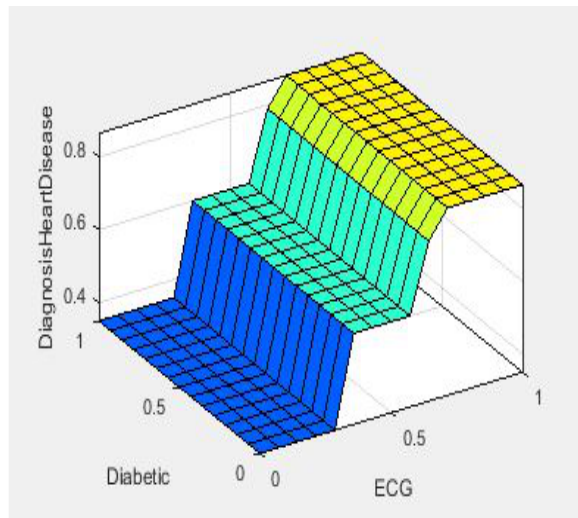
Fig. 3. Proposed DHD-MFI expert system Rule surface of w.r.t. ECG & Diabetic.